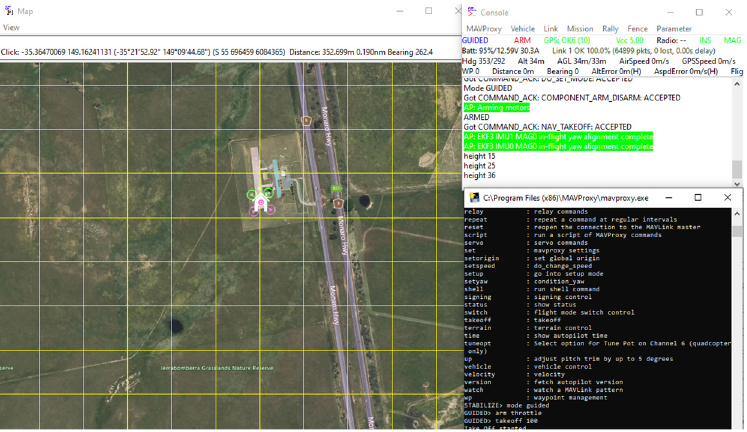
Figure 16. The running of the mpFCS on the Windows system in a simulated environment.